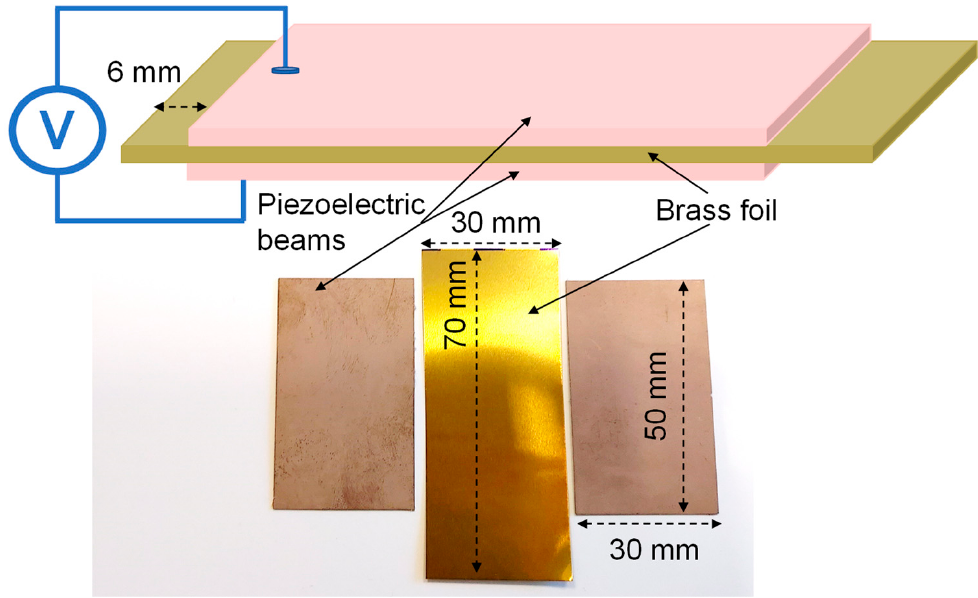
Figure 1. Bimorph piezoelectric harvester beam scheme and materials.